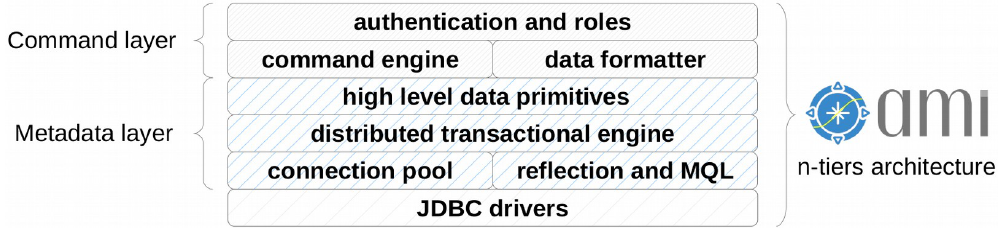
Fig. 2. Overview of AMI Java